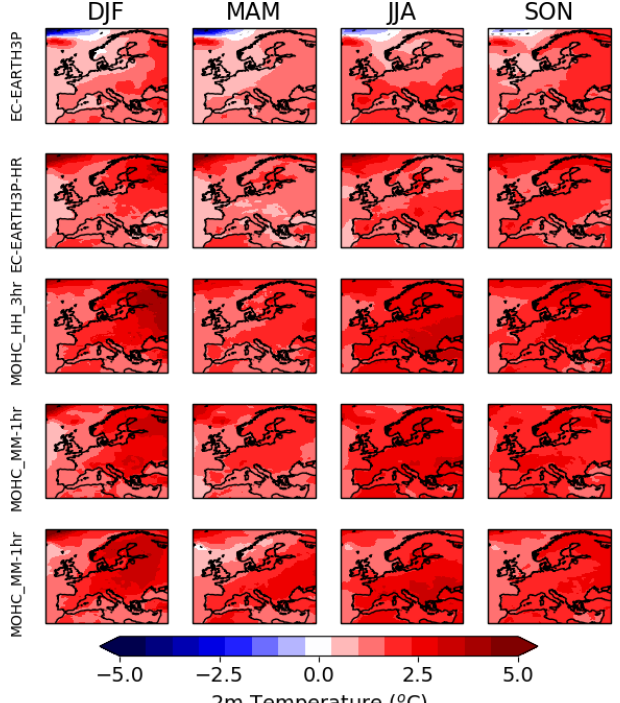
Figure A2. Seasonal-mean difference in 10m wind speed between 1980–2010 and 2020–2050 for the five different climate model sim- ulations used in this study (see Table 1 for further details of the models). Stippling shows grid points where no statistically signif- icant climate change signal was found when using a two-sample t test (Wilks,